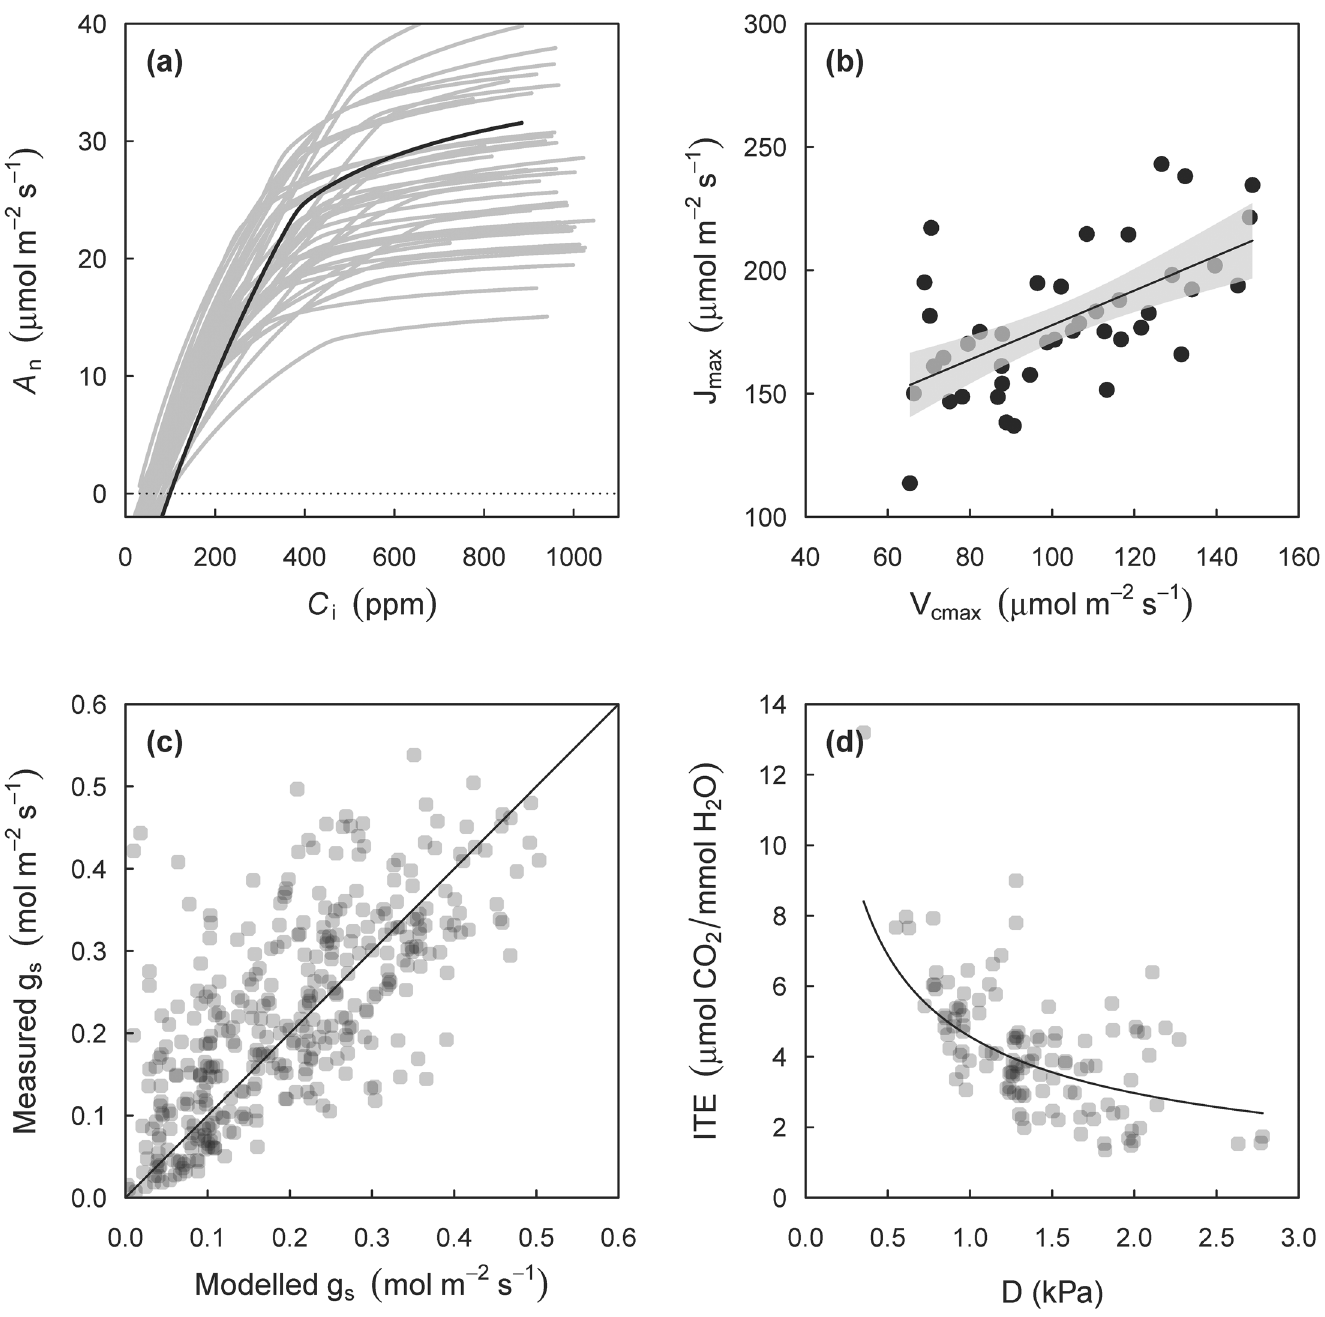
Fig 5. Example application of the plantecophys package to A-C i curves and spot gas exchange measurements on Eucalyptus delegatensis . (A) Fitted A-C i curves with one curve highlighted (B) Estimates of J max plotted against V cmax , obtained from the fitted curves in panel (A). Solid line is a regression line (J max = 107.71 + 0.7 V cmax , R 2 = 0.36) with a 95% confidence interval for the mean. (C) Modelled (with the model of Medlyn et al. 2011) versus measured g s (p < 0.0001, R 2 = 0.69). Measurements included a wide range of environmental conditions (PAR, T leaf , D). In this example, only g 1 was fit (estimate = 3.31, 95% CI = 3.15 – 3.47). (D) The predicted response of ITE (A n / E) as a function of D from the fitted model in panel (C) (solid line), and the measurements from panel (C) when PAR >